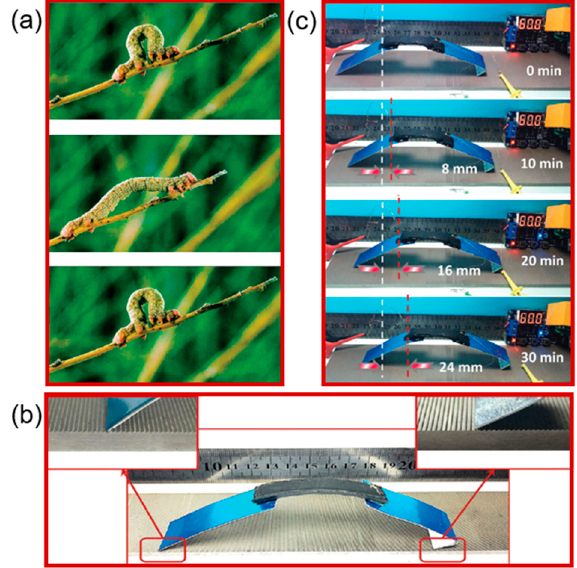
Figure 11. Application of an electro-active shape-memory polymer composite to an inchworm robot. ( a ) Photographs of inchworm locomotion. ( b ) Illustration of a designed inchworm robot with a double layer CNT–SMP composite in connection with two metal plates as moving legs. ( c ) Snapshots of an inchworm-type robot in locomotion. It has moved over 24 mm in 30 min (Reprinted (adapted) with permission [138]. Copyright (2016) Royal Society of Chemistry).